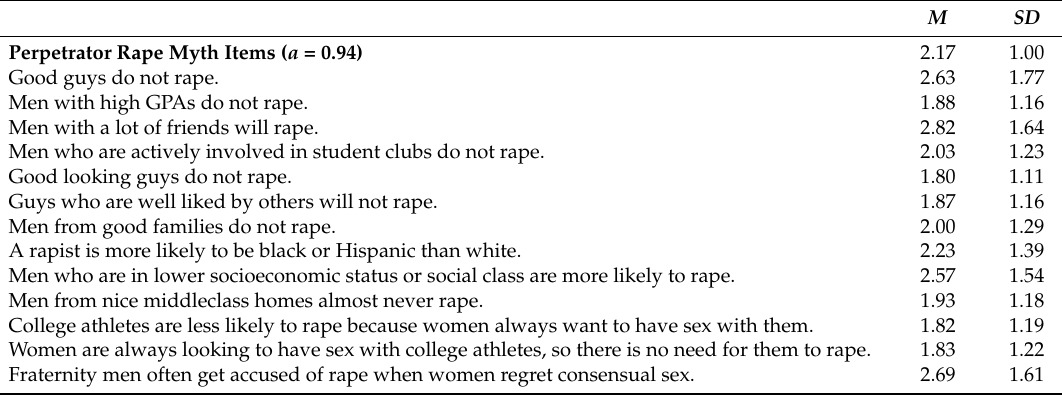
Table 1. Perpetrator rape myth